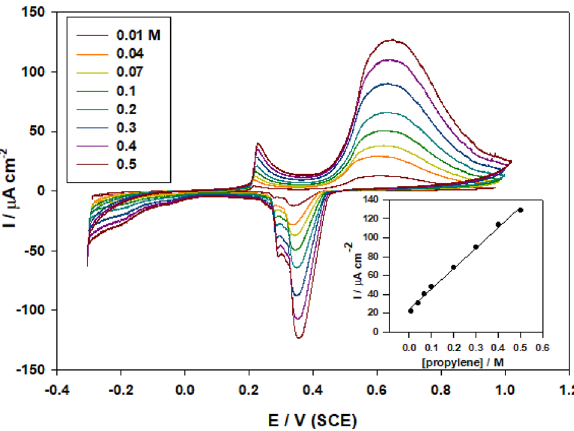
Figure 8. Effect of varying the propylene glycol concentration from (0.01- 0.5M) on the anodic peak current of SMWZCPE in 0.5 M H 2 SO 4 . Inset: the plot of the anodic peak current and the propylene glycol concentration.